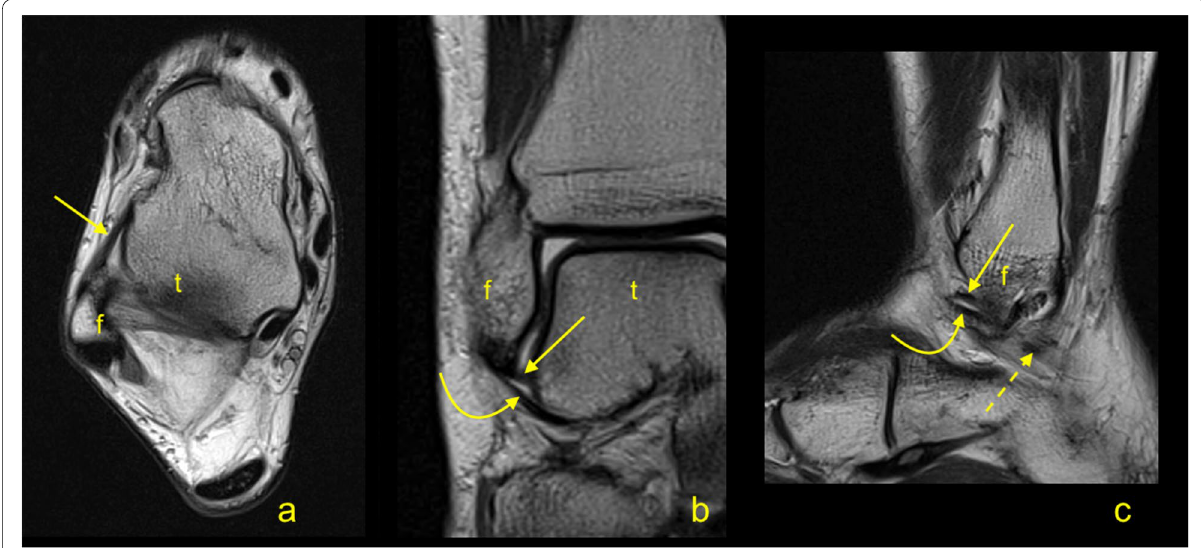
Fig. 4 A double fascicular anterior talofibular ligament. Two asymmetrical fascicles are visible; the bigger one is located in a superior position (arrow), and the smaller one inferior (curved arrow). A T2-weighted sagittal section; b and c T2-weighted axial section; d and e T2-weighted coronal section. F, fibula; t,